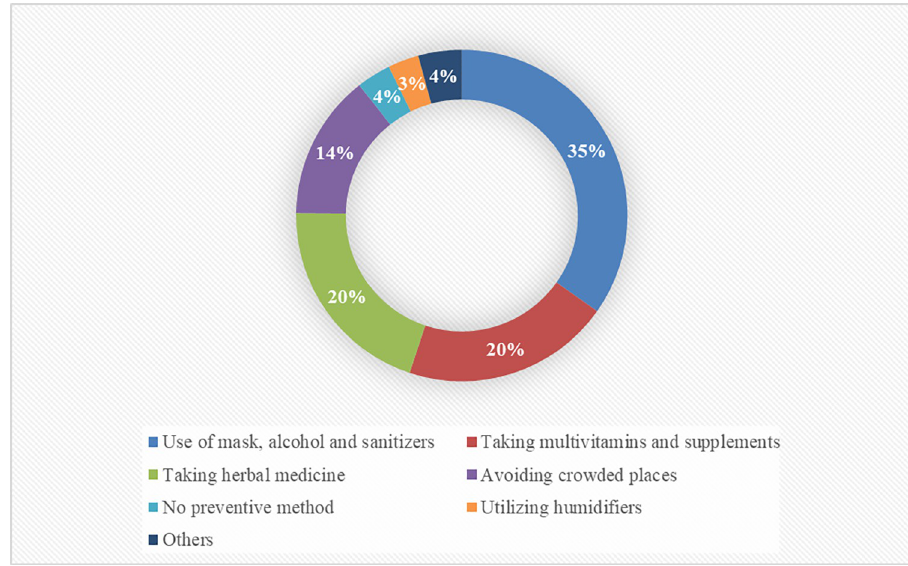
Fig 3. Response rate to the question of "What do you do to prevent contracting COVID-19?" among the unvaccinated population in Shiraz, Iran.